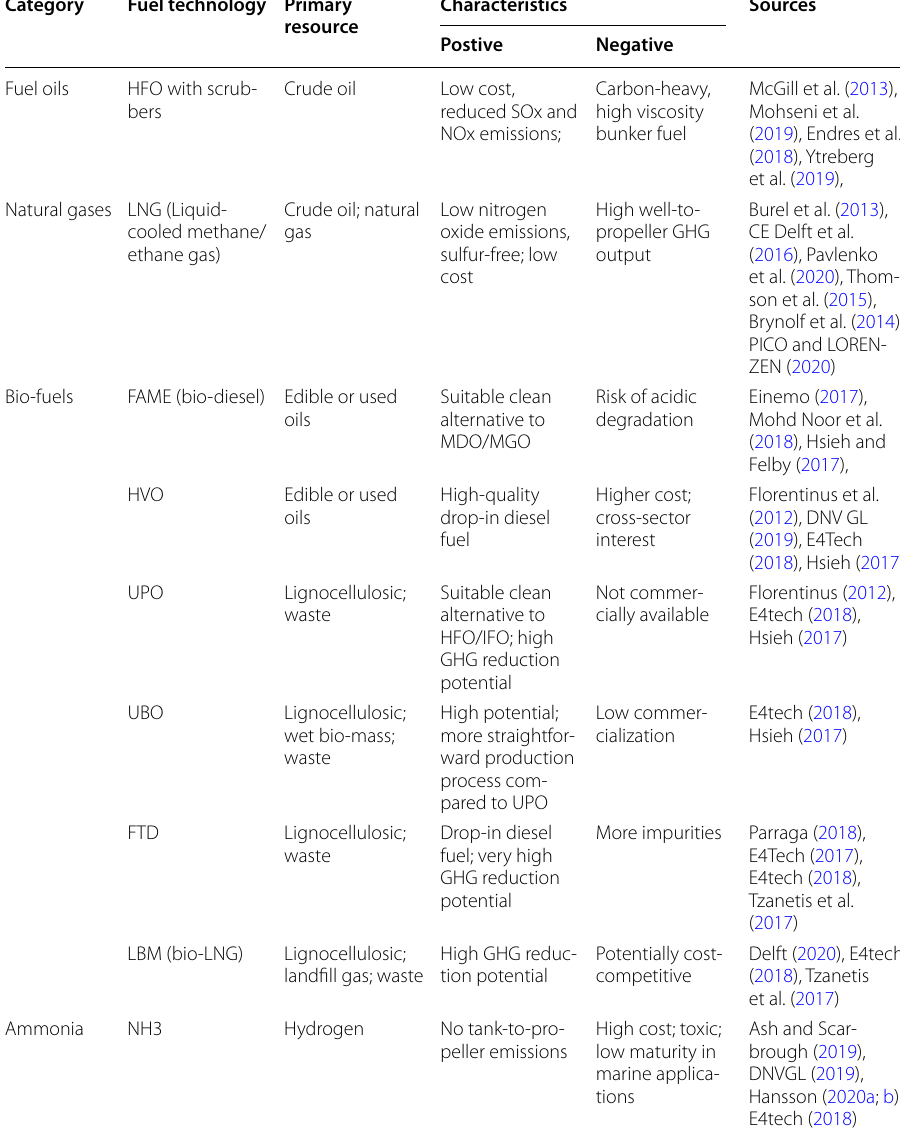
Table 1 Selection of alternative maritime fuels in the research. Source own figure based on cited